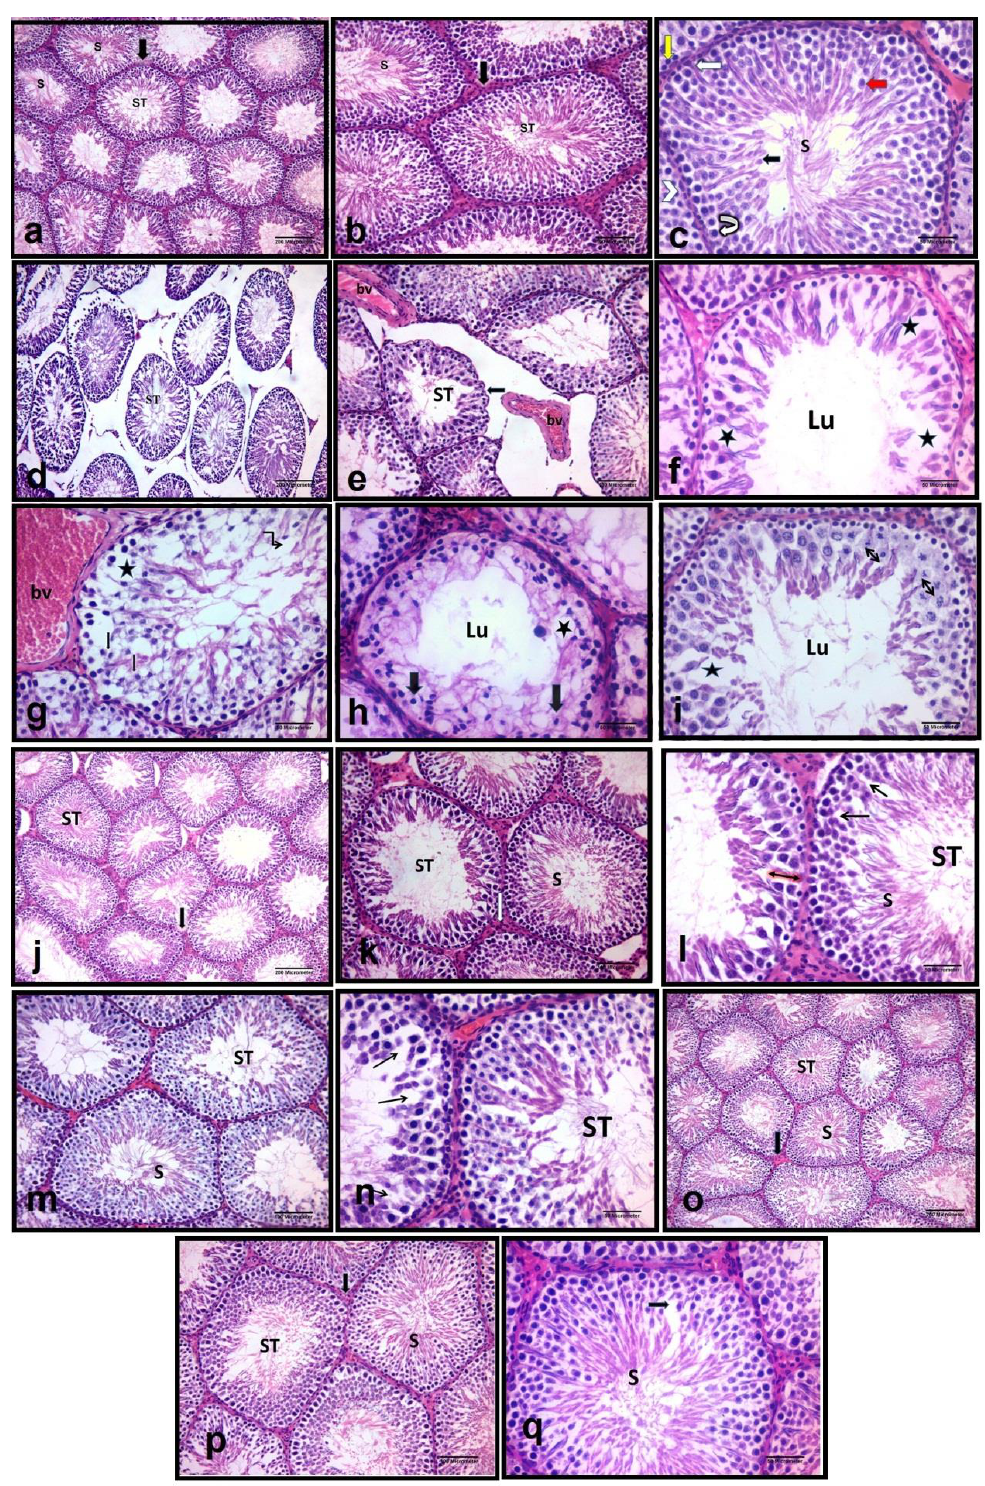
Figure 1. Representative photomicrographs of H&E-stained testicular sections from experimental groups. CON group : showed ( a , b ): ST = the seminiferous tubules; Arrow = the interstitial tissue; S = the sperms within the lumen of the seminiferous tubules. ( c ): Arrowhead = myoid cells; Straight white arrow = Sertoli cells; Yellow arrow = spermatogonia; Curved white arrow = primary spermatocytes; Red arrow = spermatid; S = the sperms; Black arrow: the lumen of the tubule. CIS